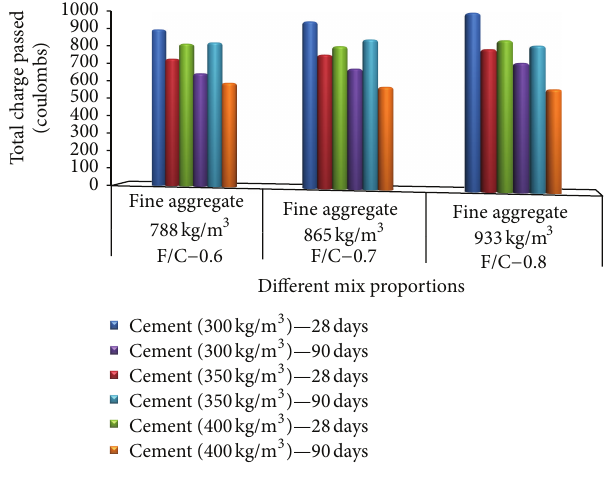
Figure 3: RCPT for various mixture proportions of concrete without quarry dust.